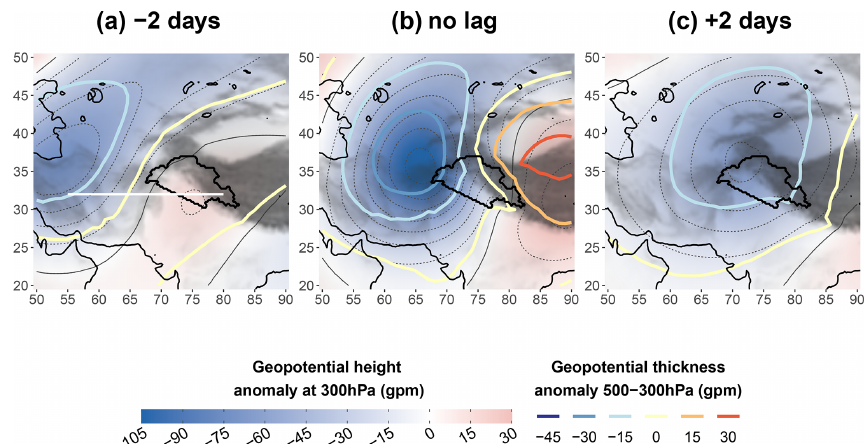
Figure 3. Composite maps of a geopotential height anomaly at 300hPa (colour shading, thin contour lines every 15gpm) and a geopoten- tial thickness anomaly at 500–300hPa (thick contour lines). Values are an average based on the 10% highest values of the 700hPa wind contribution during winter (UV700, panel b ). For panel (a) (panel c ) a 2d lead (lag) is applied to the selection. The white line in panel (a) indicates the cross-section in Fig. 4. The relief (grey shading) and coastline are based on ERA5 data. The UIB is indicated in each panel. Non-significant anomalies at the 95% level are shown in white (result of a t test on the means). Note that the thickness anomaly is directly indicative of temperature anomalies in that layer under the hydrostatic